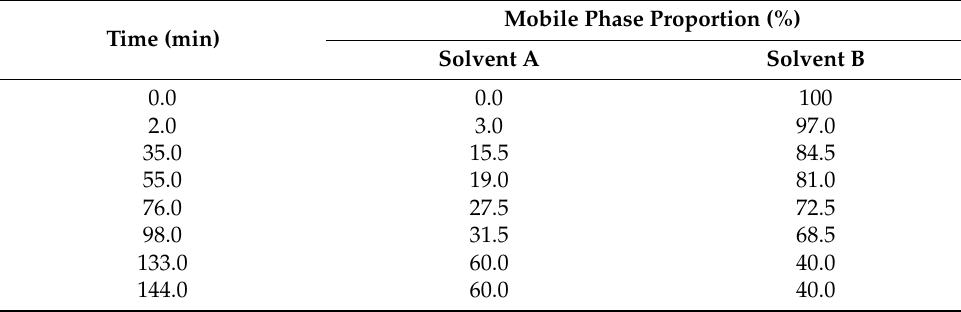
Table 3. Gradient system used to isolate compounds on preparative